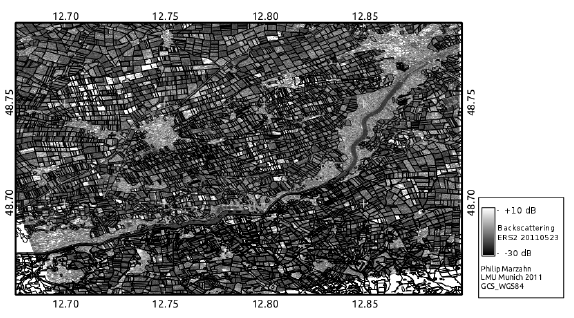
Figure 4: ERS-2 scene, acquired at the 23 of May 2011, over the Wallerfing test site, indicating strong directional